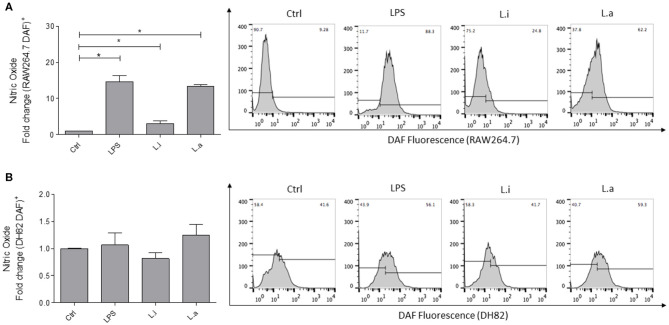
Intracellular nitric oxide (NO) production in murine (RAW264.7) and canine (DH82) macrophages. RAW264.7 (A) and DH82 (B) macrophages were stimulated with 1 μg/mL LPS or infected with 5p:1 m of L. infantum (L.i) or L. amazonensis (L.a) and NO production measured using DAF-FM. Data were normalized as fold change in comparison to control cells (unstimulated cells incubate with DAF) and are presented as mean ± SEM of three independent experiments. *p < 0.05. Representative histograms of %DAF-FM+ cells in unstimulated cells (Ctrl), stimulated with LPS, or infected with L. infantum or L. amazonensis are shown.